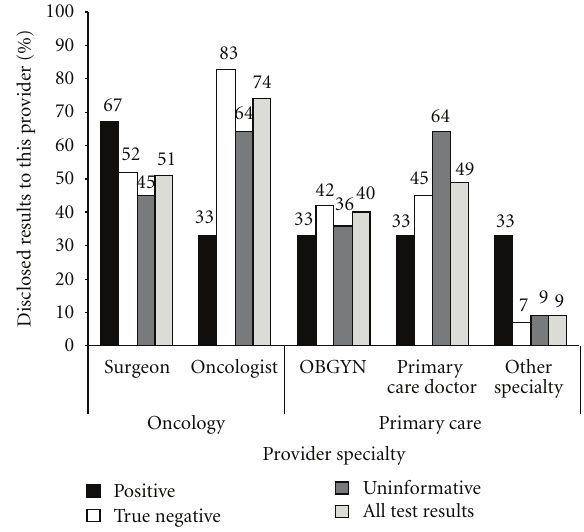
Figure 2: Patients’ report of sharing test results by provider specialty and mutation